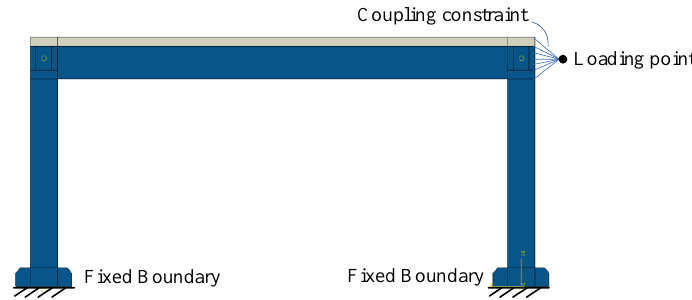
Figure 7. Loading mode of the numerical model.